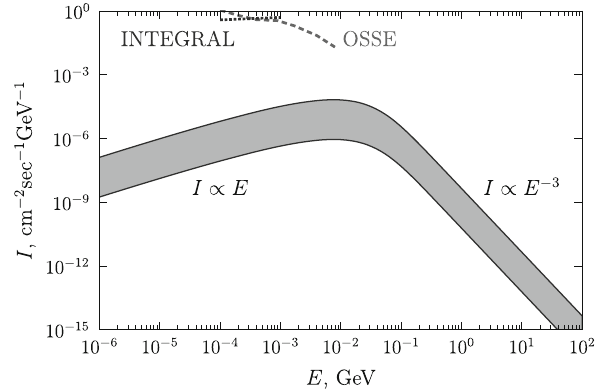
Fig. 13 Energy absorption rates for allprocesses considered: ˙ (cid:15) ( e − ion ) , abs (γ) ˙ (cid:15) ( e − ann ) and their sum, ˙ (cid:15) and the total rate, for M = 5 × 10 16 g. abs abs Light gray lines relate to the respective losses obtained approximately (see [152,153]). ˙ (cid:15) ev is shown to illustrate total evaporation rate into all species and e ± + γ